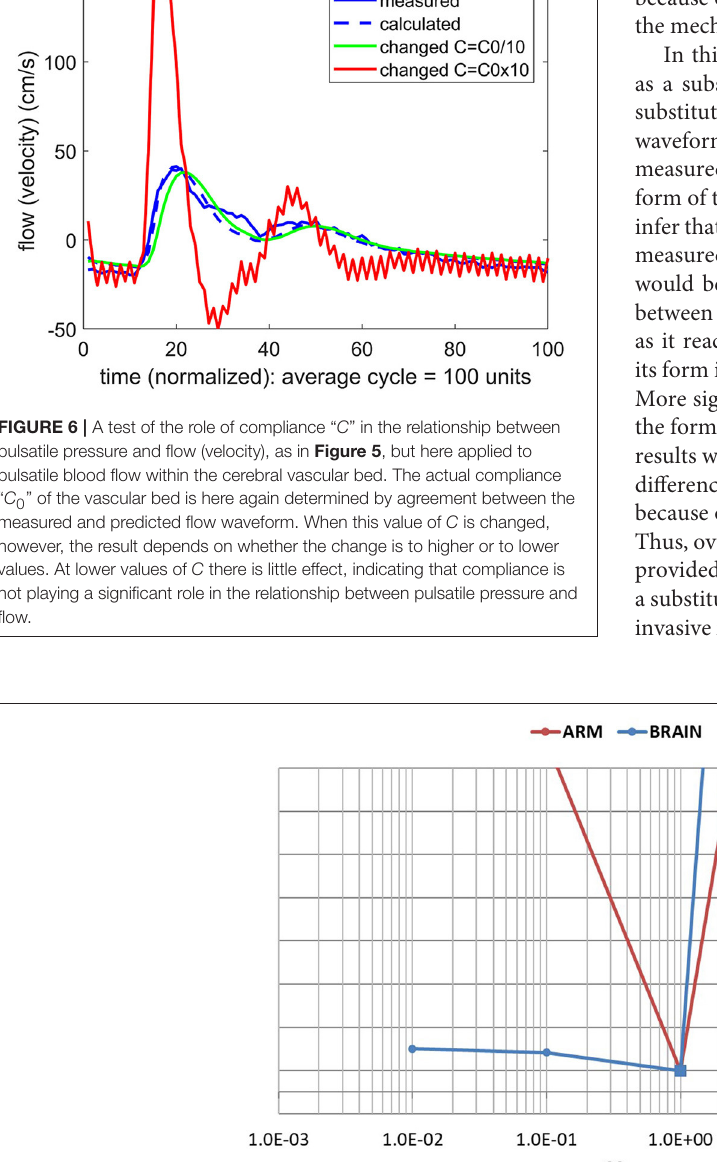
Frontiers in Physiology |